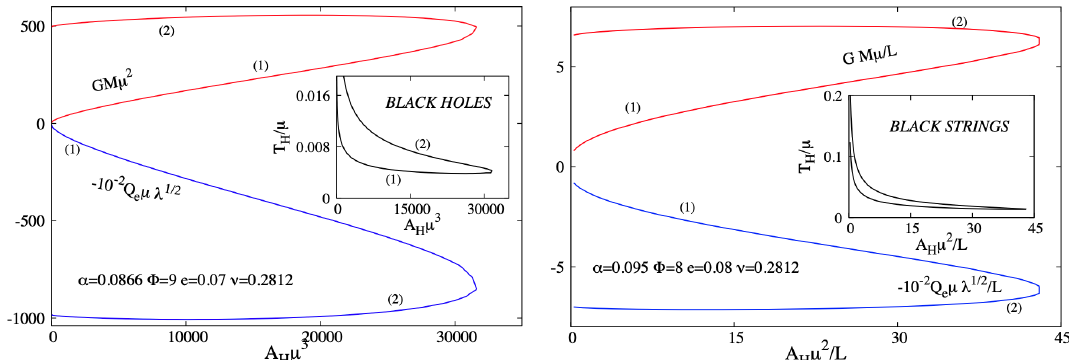
Figure 2 . The mass, electric charge and Hawking temperature of solutions are shown as a function of event horizon area for BHs and BSs. The quantities are shown in the natural units of the model.